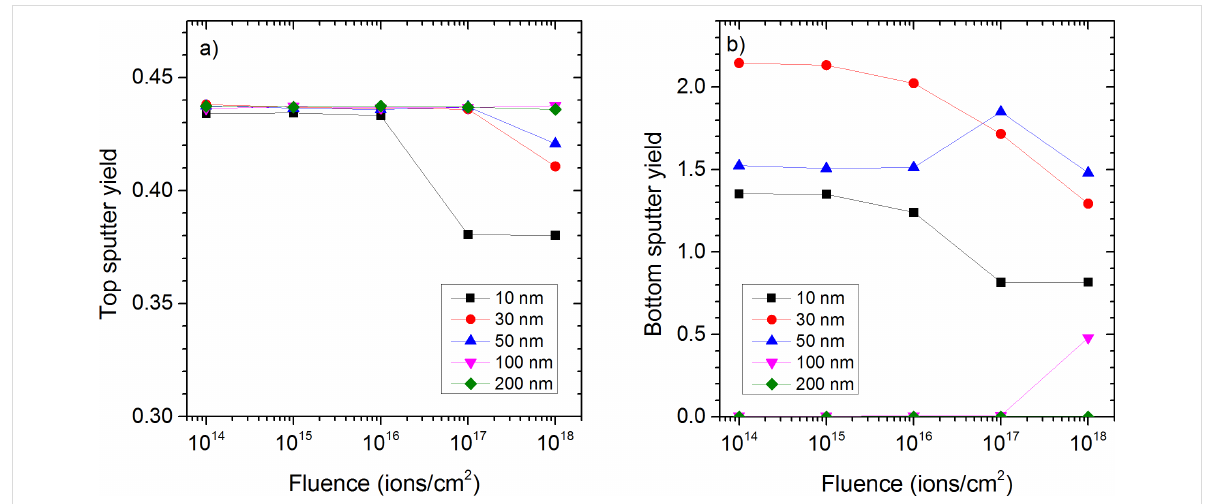
Figure 5: Sputter yield a) at the top, and b) at the bottom of the sample as a function of fluence for Ne irradiation of carbon samples of different thick- nesses of 10–200 nm.